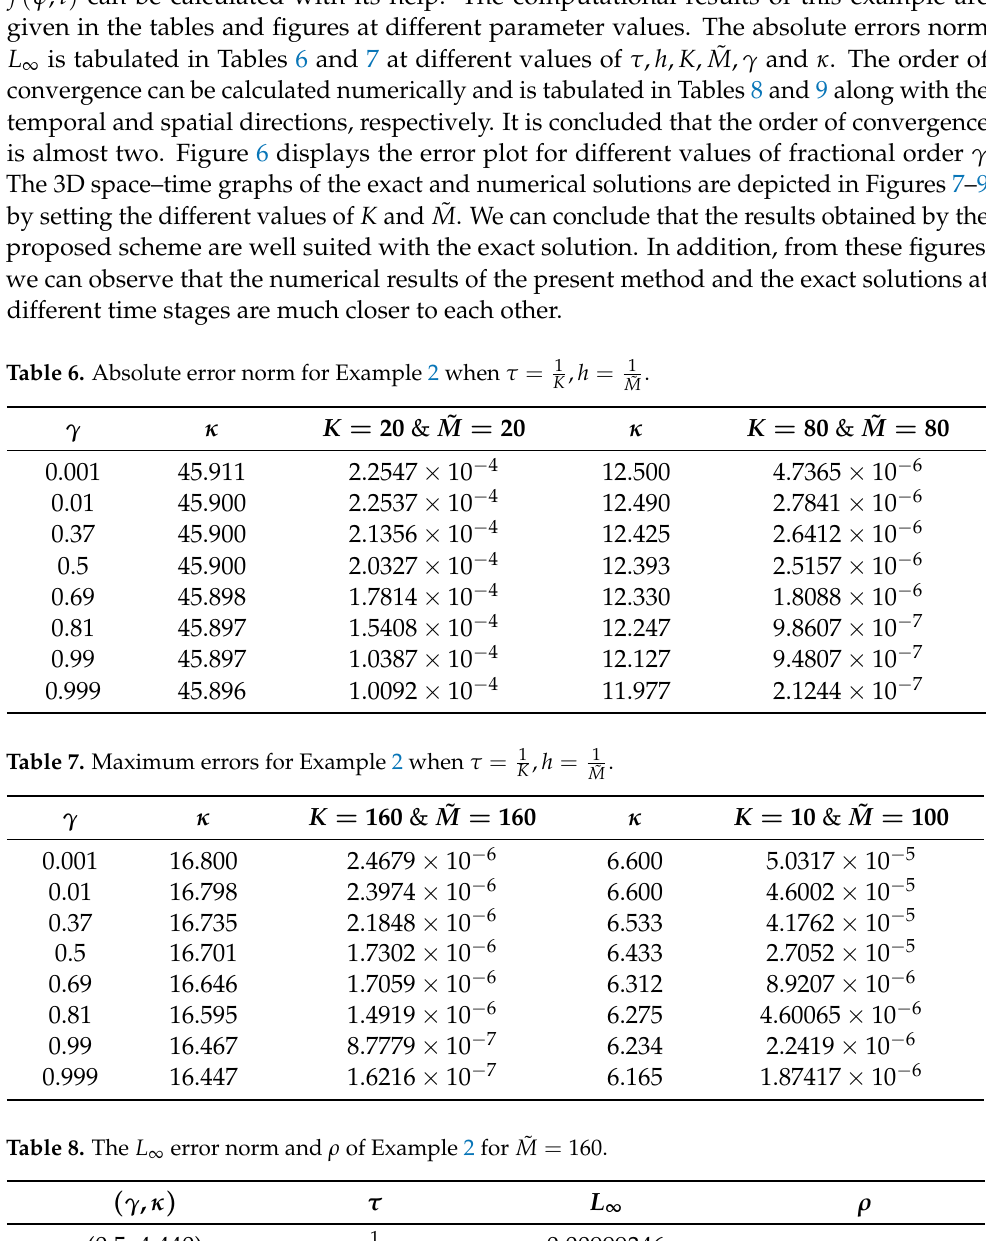
Table 6. Absolute error norm for Example 2 when τ = 1